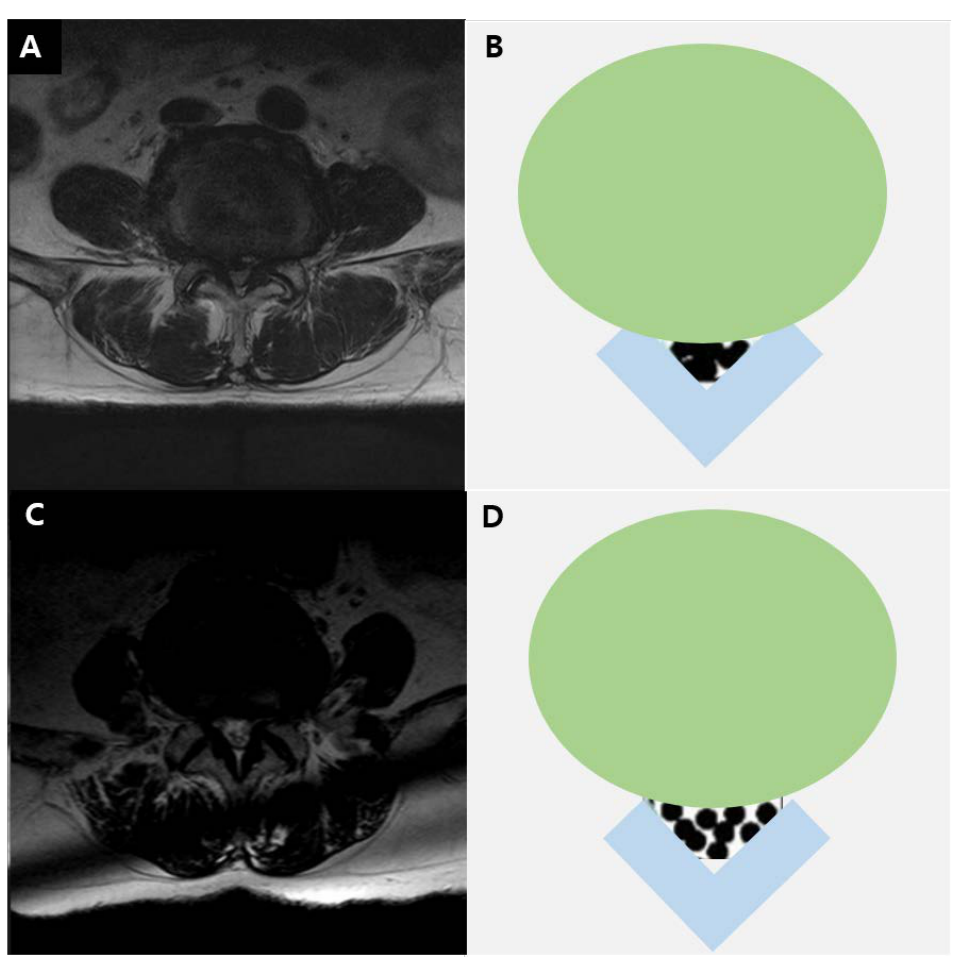
Figure 1. T2-weighted axial magnetic resonance image in a 73-year-old man ( A ) and diagram ( B ) showing severe lumbar stenosis. T2-weighted axial magnetic resonance image in a 70-year-old man ( C ) and diagram ( D ) showing moderate lumbar stenosis.